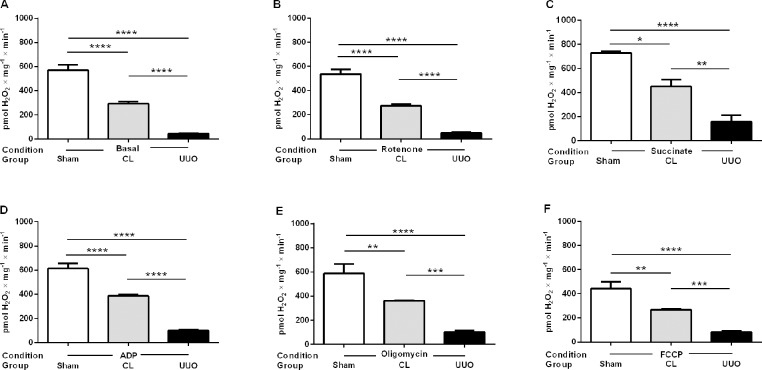
H2O2 production by mitochondria from Sham, CL, and UUO kidneys in the presence of substrate for complex II and rotenone.H2O2 was measured in respiring mitochondria in basal conditions (no exogenous substrates) (A), and after successive additions of rotenone (B), succinate (C), ADP (D), oligomycin (E), and FCCP (F), as shown on the abscissae. Data represents means ± SEM from 3 (Sham) or 5 experiments (CL, UUO) using different mitochondrial preparations. Statistical analysis was performed using one-way ANOVA followed by Tukey’s test. *p<0.05, **p<0.01, ***p<0.001, ****p<0.0001.